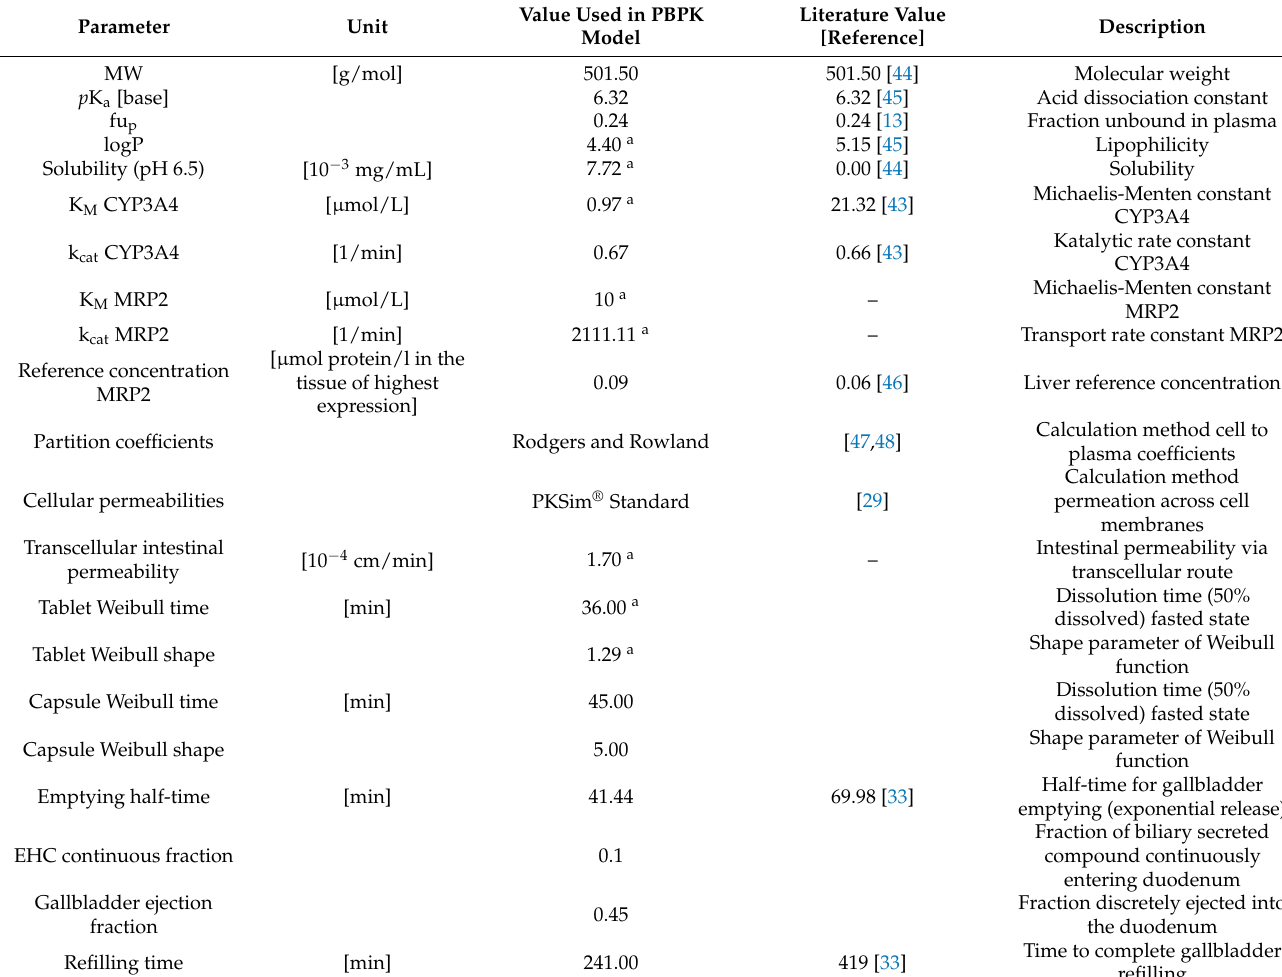
Table 1. Summary of the CAB parameters used in the human PBPK